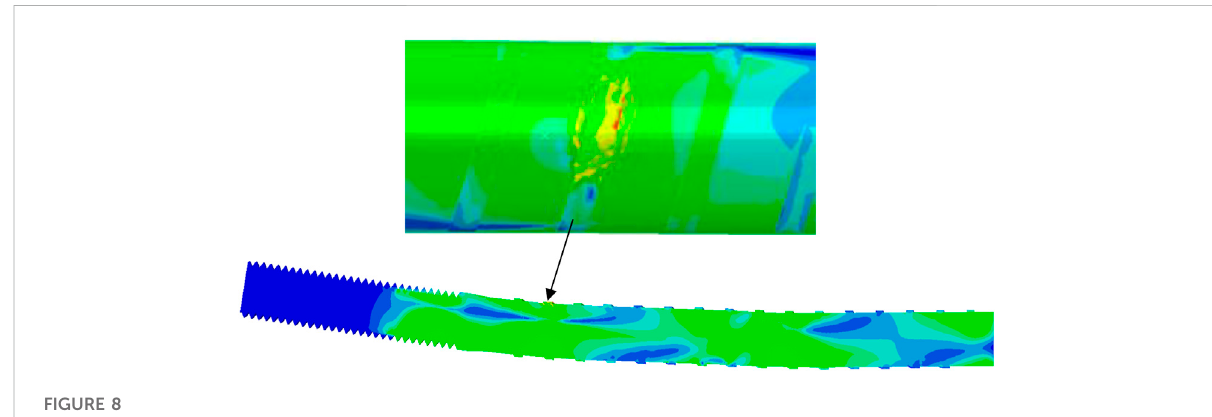
FIGURE 8 Stress concentration of bolt under composite stress